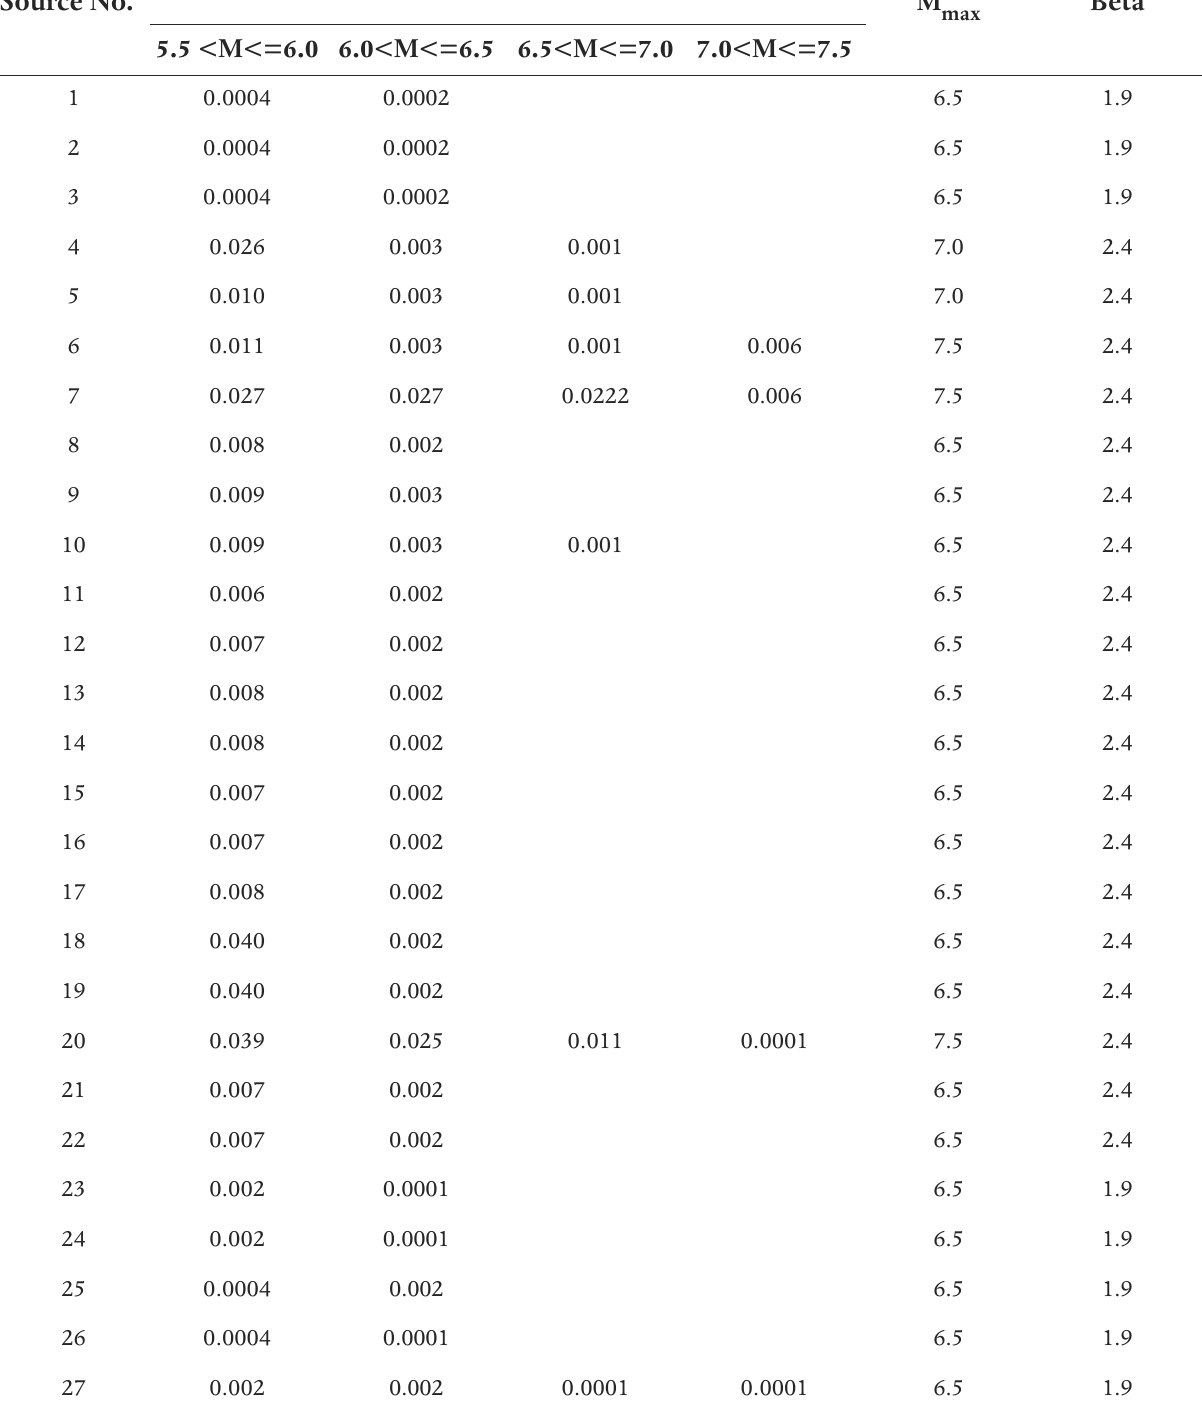
Table 1. The seismic parameters of potential seismic sources of the study region and surrounding